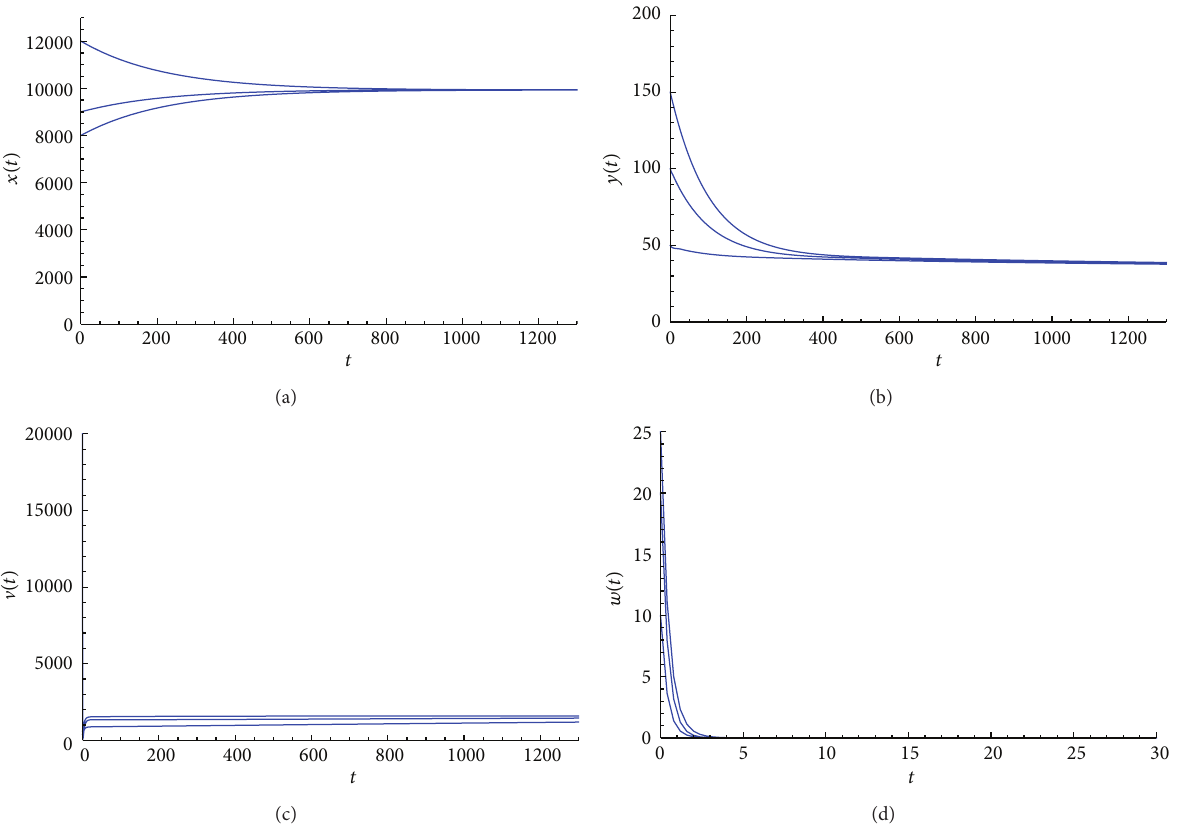
Figure 2: Trajectories of 𝑥(𝑡) , 𝑦(𝑡) , V (𝑡) , 𝑤(𝑡) for R 1 0 = 1.07872 , R 1 1 = 0.982187 , and 𝐸 1 = (9924.5, 34.7292, 1576.57, 0) are globally asymptotically stable. 𝑥(𝑡) , 𝑦(𝑡) , V (𝑡) , and 𝑤(𝑡) versus 𝑡 are illustrated by (a), (b), (c), and